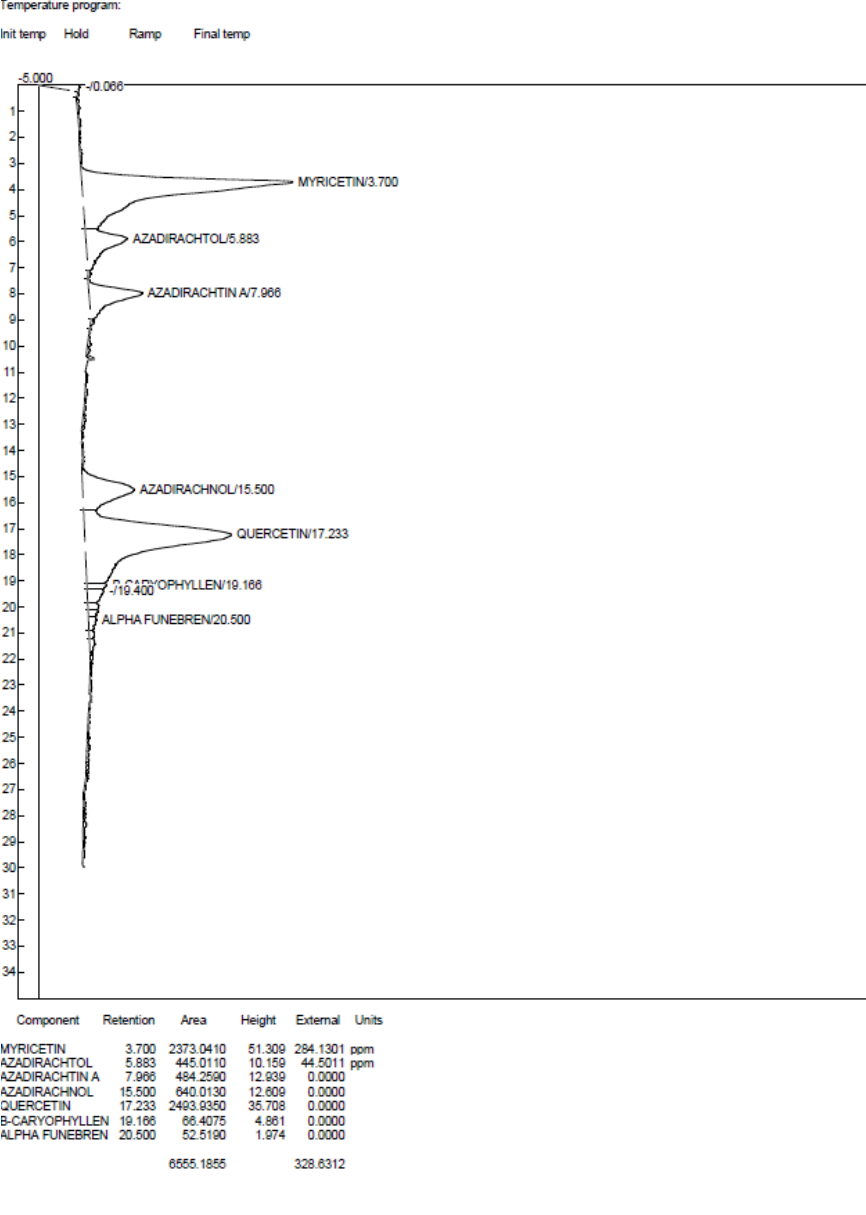
Figure 5. Chromatogram of acetone extract of A. indica